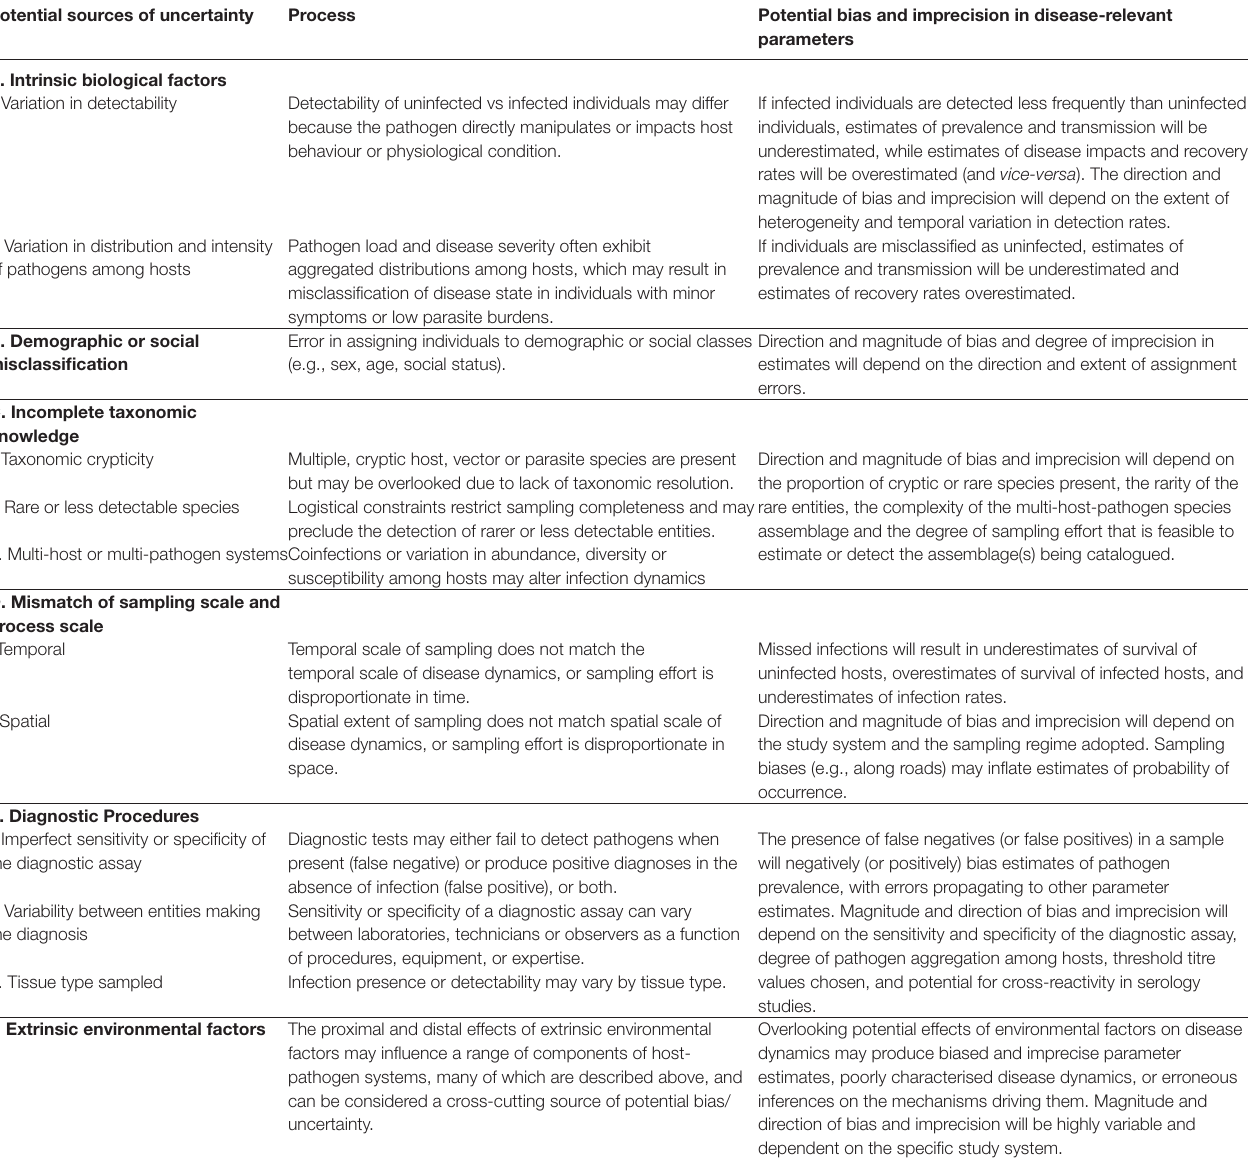
TaBle 2 | Summary of key sources and processes that can generate bias or lack of precision in estimates of disease-relevant parameters obtained in disease ecology